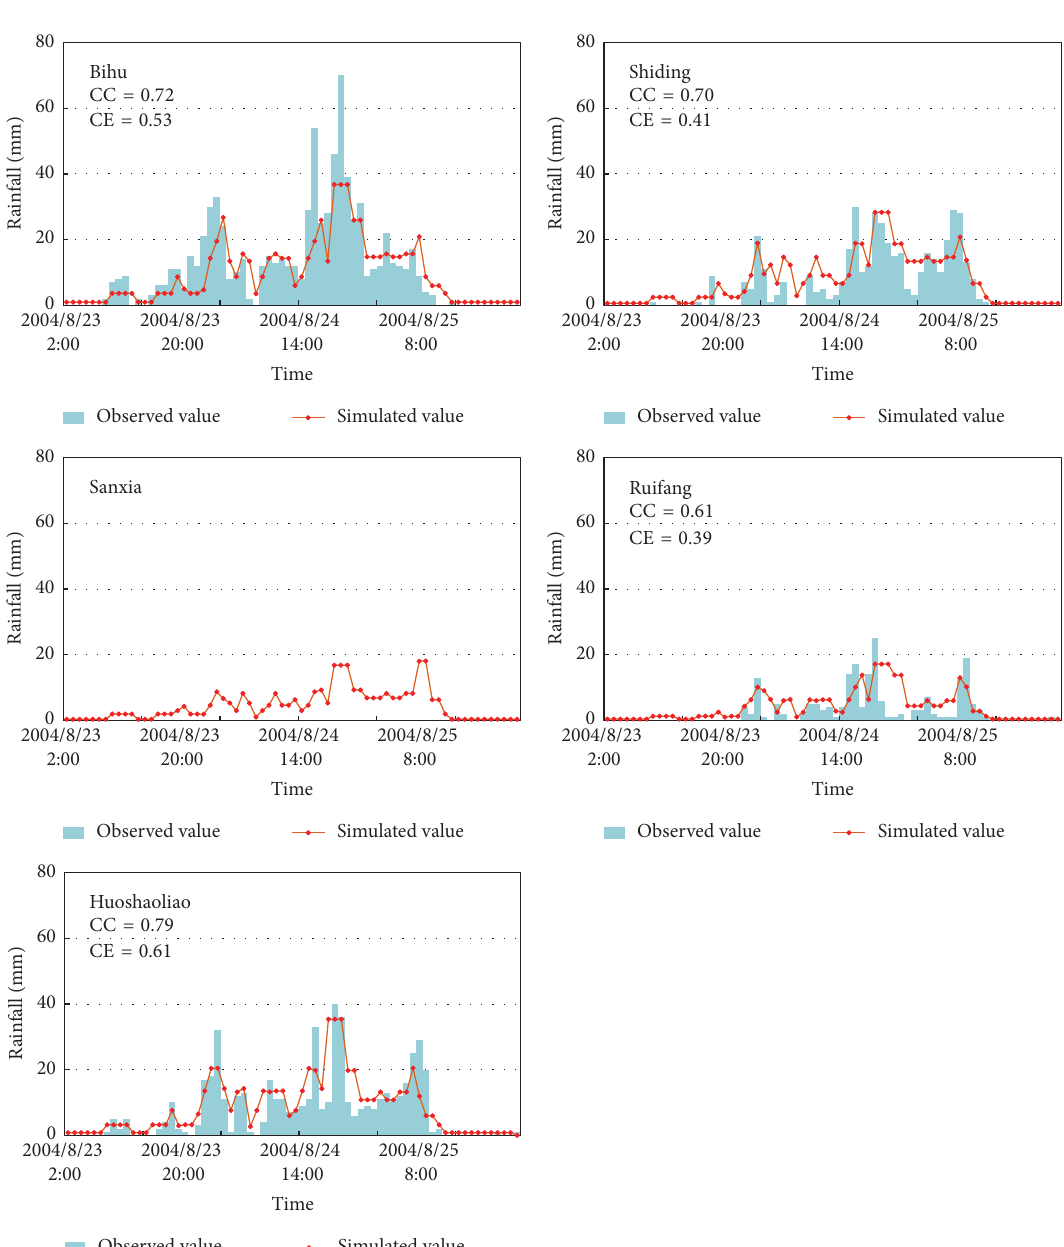
coefficient of efficiency is 0.64 and reasonably good results have been observed. We thus think that the improvement is